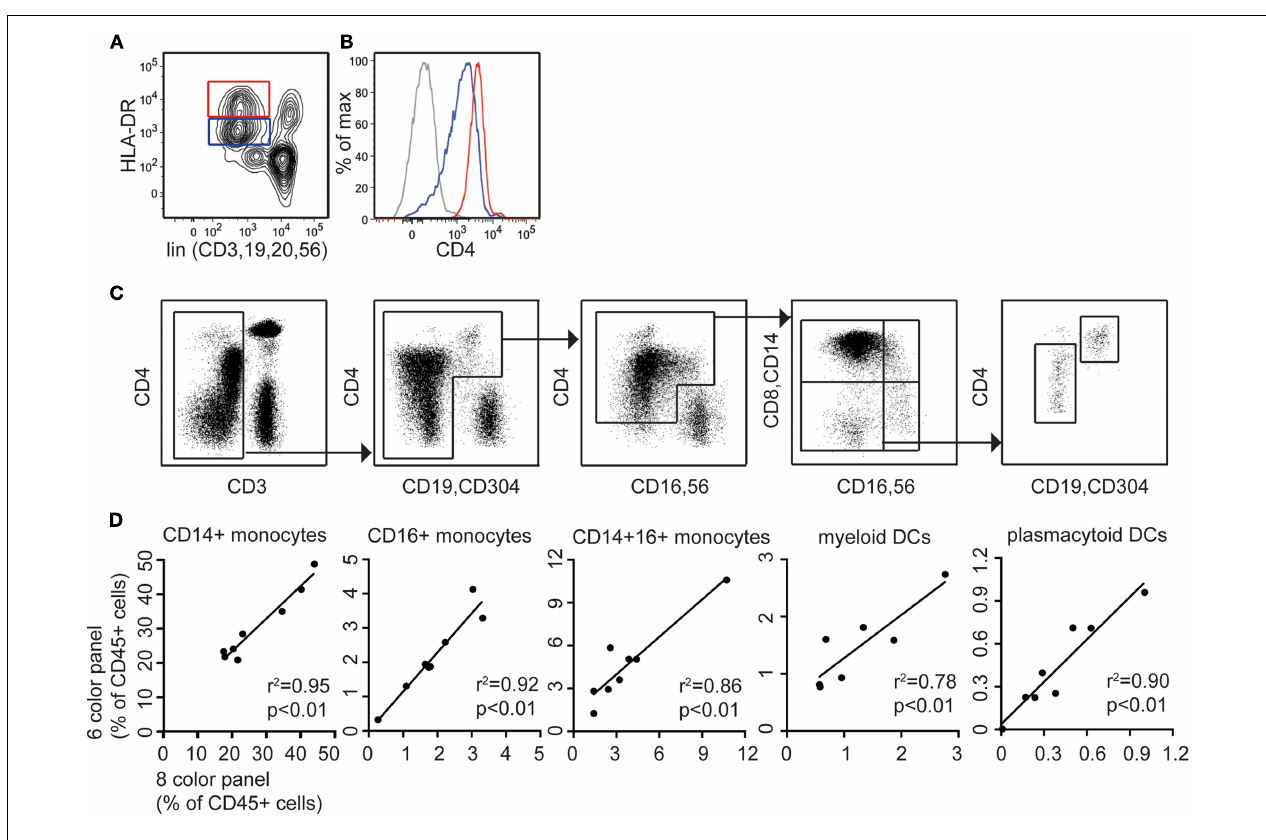
mobilized blood. (B) CD4 expression is highest on lin − DR bright cells but also positive on lin − DR low cells. (C) The modifiedTBNK assay applied to G-CSF mobilized peripheral blood stem cells (PBSC) permits effective discrimination of lymphocyte, monocyte, and DC populations. (D) Correlation between 8-color and modifiedTBNK methods for DCs and monocytes in